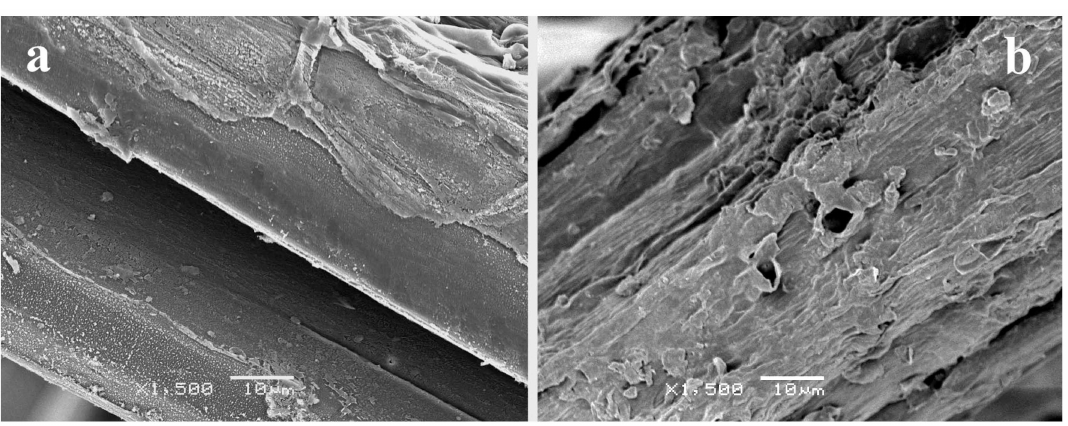
Figure 4. SEM image of surfaces of samples ( a ) NW C-Cr1010; and ( b ) NW C-Cr20 taken at 10 kV and ˆ 1500 magnification.